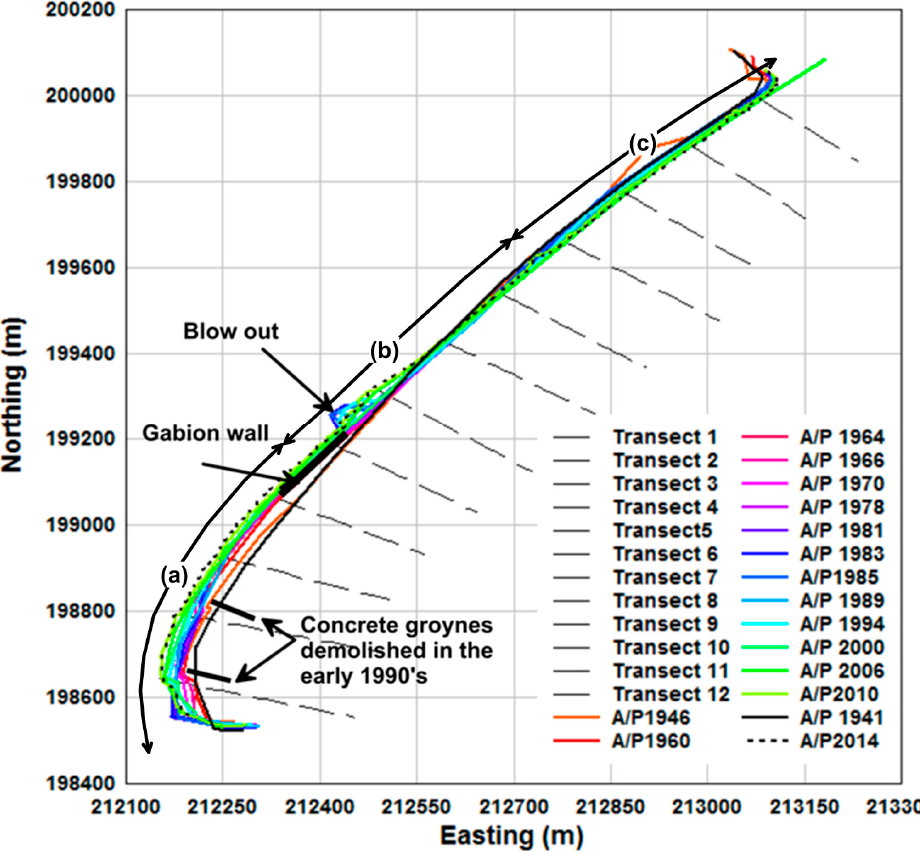
Figure 4. Shoreline positional change 1941–2014 produced from Table 4 represented graphically for ( a ) southern; ( b ) central and ( c ) northern beach sectors.